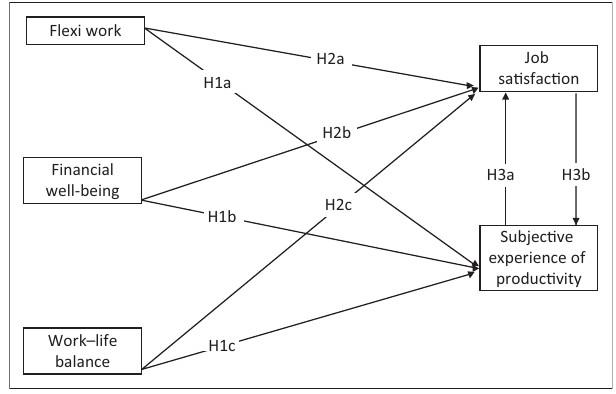
FIGURE 1: The hypothetical